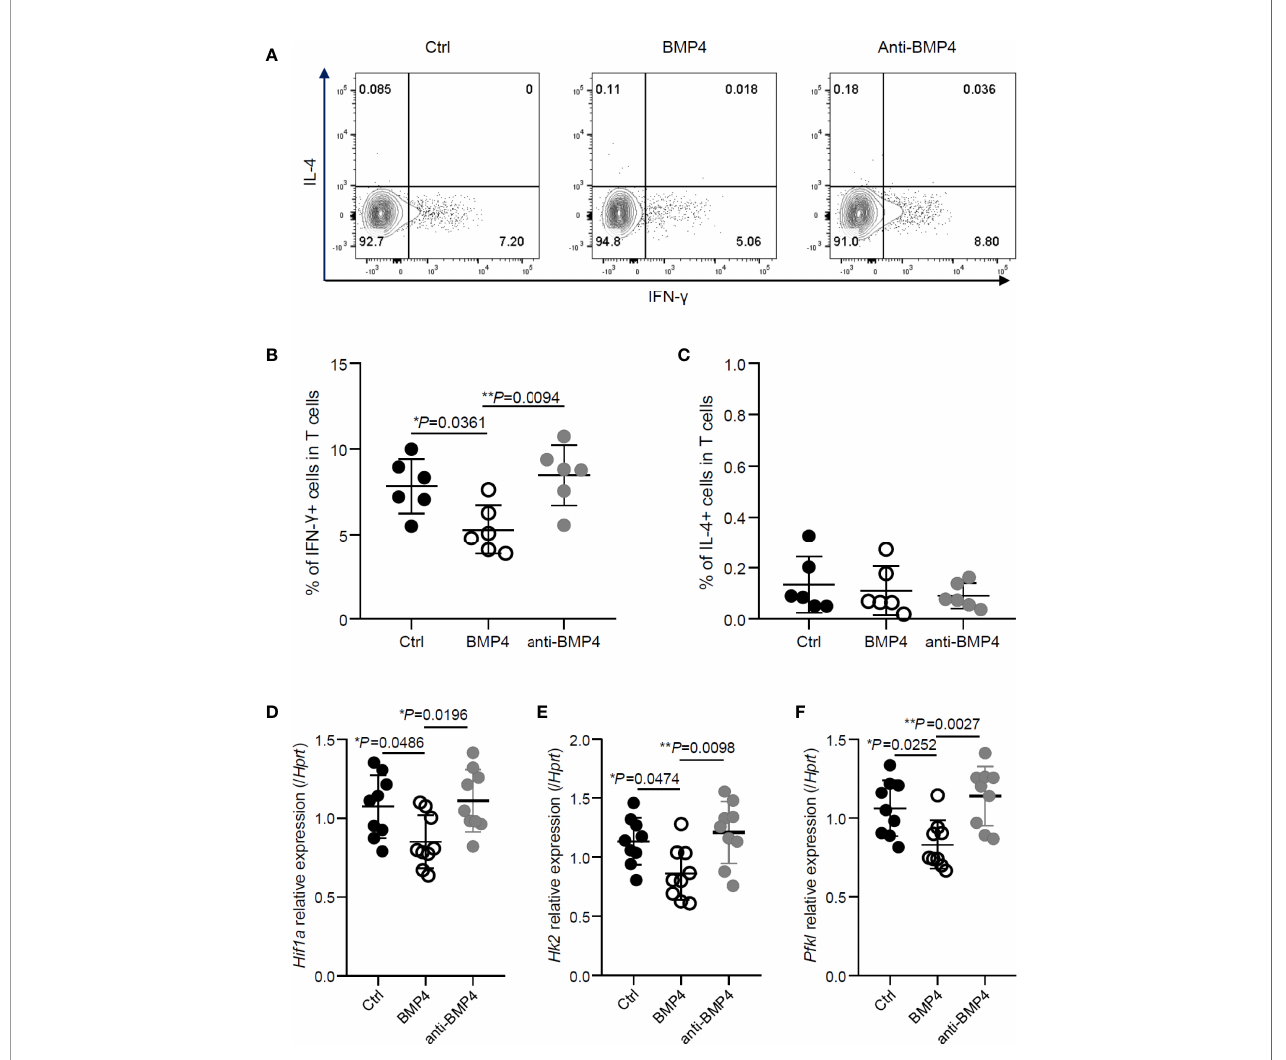
FIGURE 4 | BMP4 suppresses the IFN- g production in CD4+ T cells in vivo . (A) OT-II CD4+ T cells were adoptively transferred to CD45.1 transgenic C57BL/6 mice and injected OVA peptides into the footpads. The expression of IFN- g and IL-4 on T cells from the draining lymph nodes of footpads with or without administration of BMP4 or anti-BMP4 antibody treatment. (B) The frequency of IFN- g + T cells. (C) The frequency of IL-4+ T cells. (D – F) The gene expression of Hif1a, Hk2, Pfkl checked by Quantitative real-time